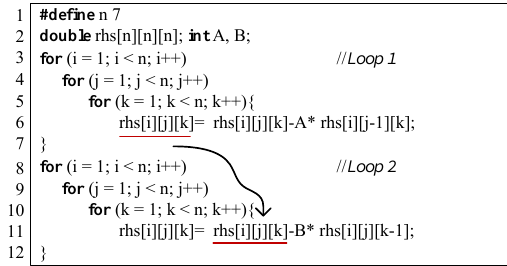
Figure 7. Code to illustrate data-reorganization communication